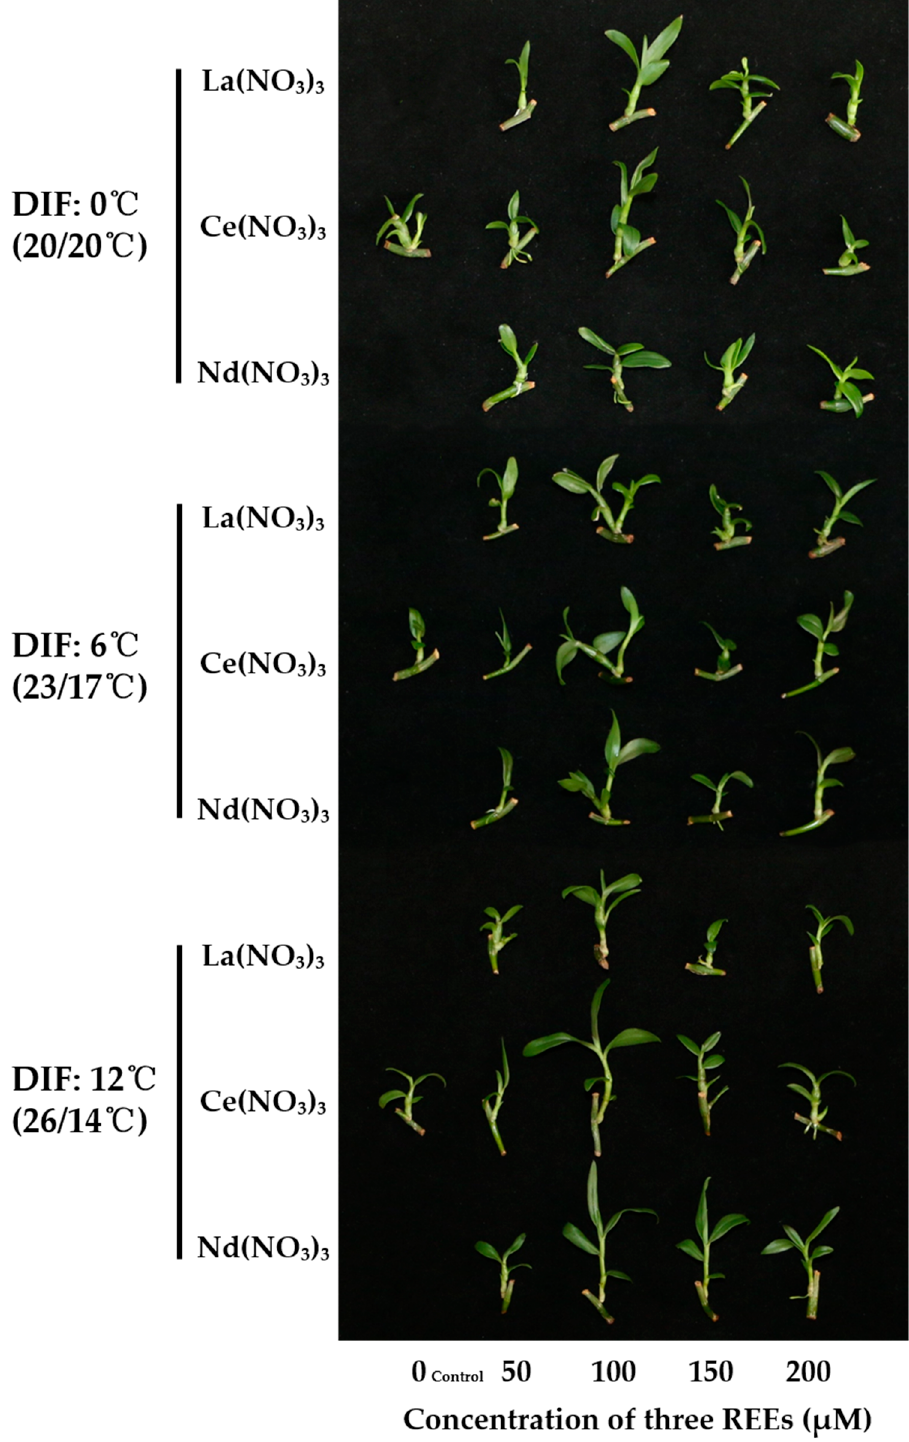
Figure 4. Effects of DIF and REE supplementation on the morphology of D. aphyllum after four weeks of treatments.